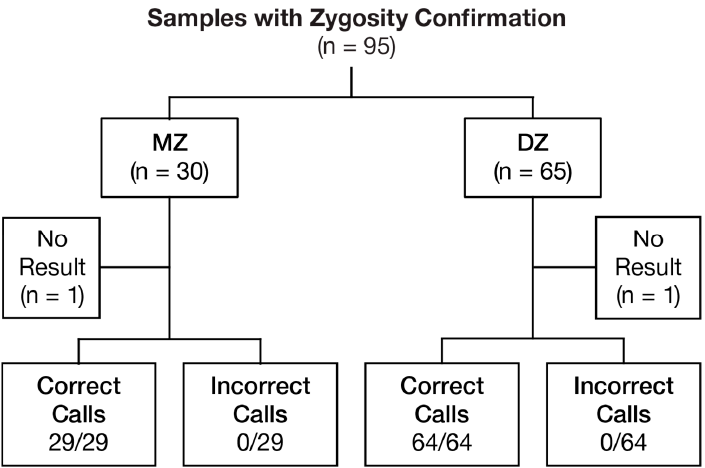
Figure 2. Zygosity determination. MZ—monozygotic; DZ—dizygotic.